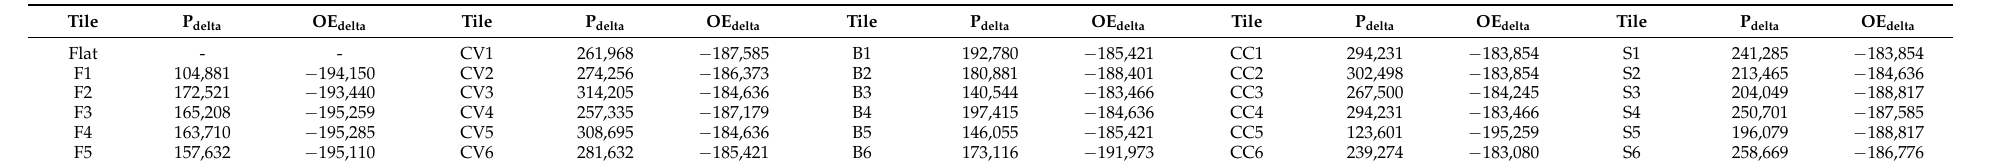
Table 7. Quantity of surplus material for production delta (Pdelta; kg) and saved energy for operational energy delta (OEdelta; kWh/whole building · 50 yr) for exterior sculptured tile compared to flat tile covering for typical 9-story residential